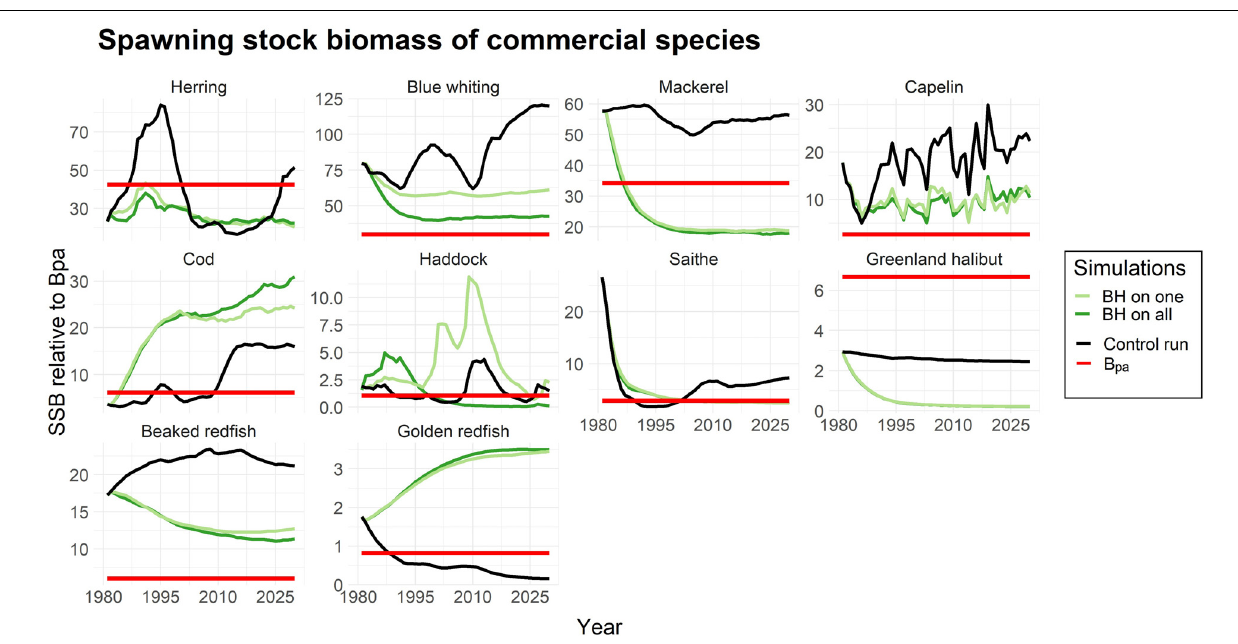
avoid bias from unsustainable short-term spikes in catches during the first years after implementation, as well as any other short- term dynamics imposed by the change of fishing